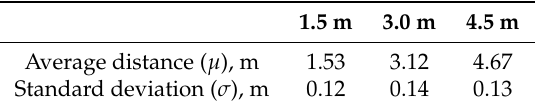
Table 1. Characteristics of the distance error measurements using a depth sensor relative to the true distance at which the subjects had been